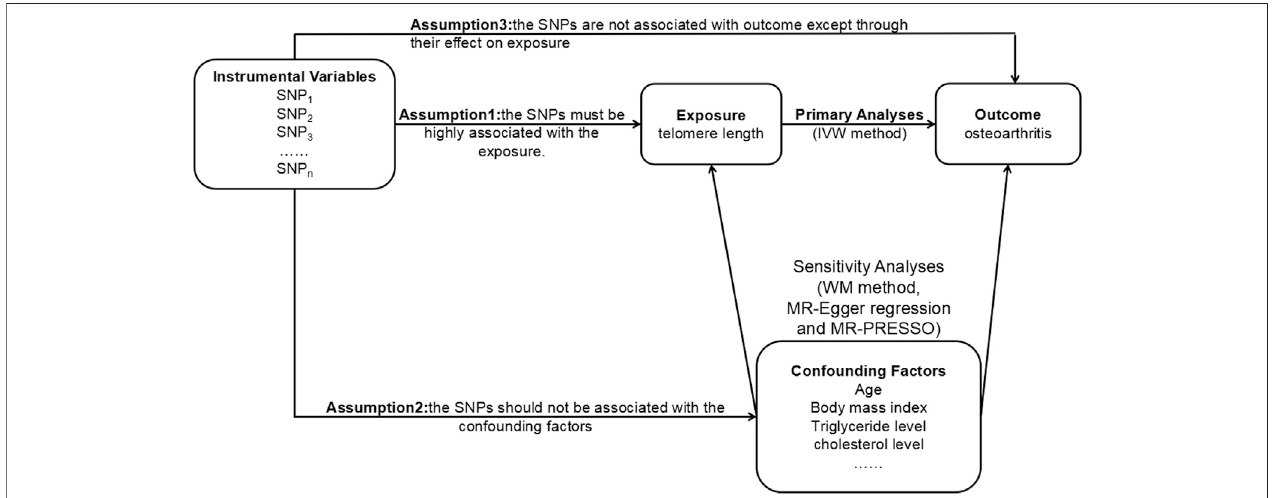
FIGURE1| TheprinciplesoftheMRmethod.MR,Mendelianrandomization;SNP,singlenucleotidepolymorphism;IVW,inversevarianceweighted;WM,weighted median; MR-PRESSO, MR pleiotropy residual sum and outlier.